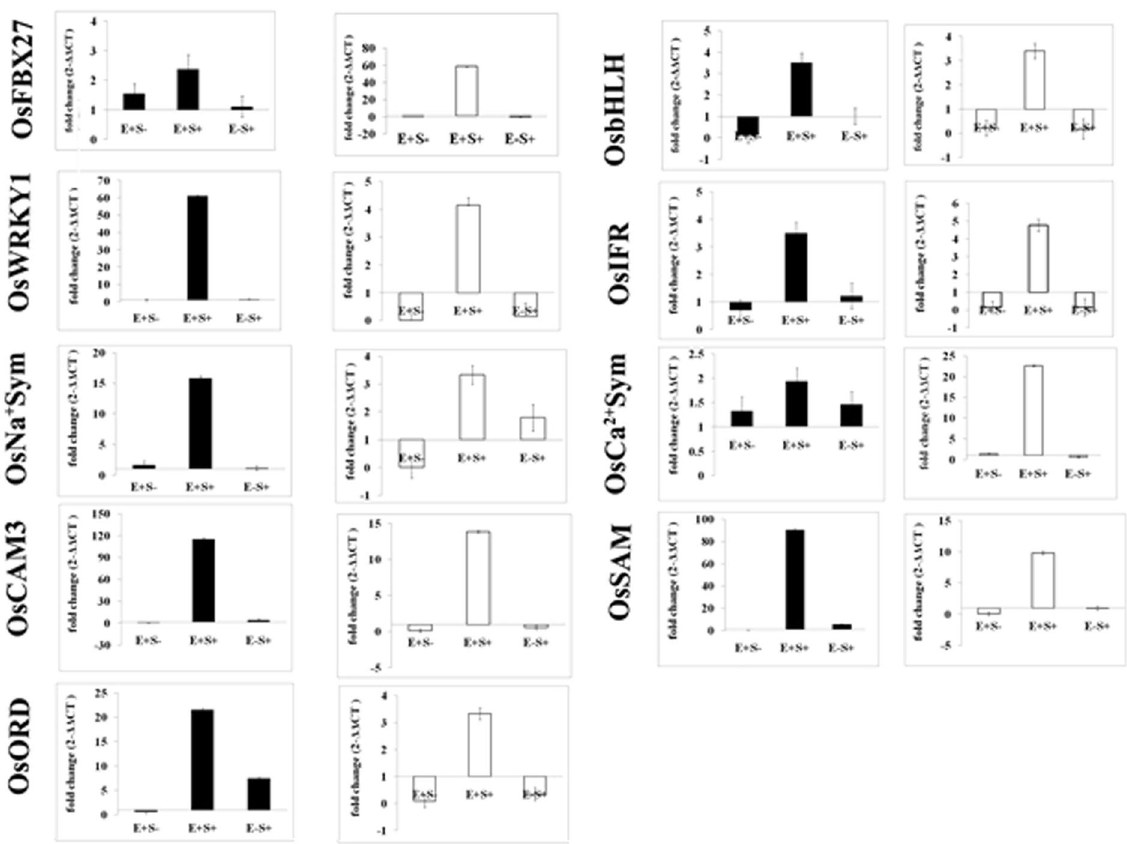
Figure 6. Validation of nine selected DGEs by qPCR. Gene expression levels at E + S − , E + S + and E − S + of shoot and root were compared to E − S − and UBQ10 (Endogenous gene) of shoot and root respectively. Black bars represent shoot and white bars represent root. Errors bars indicate mean ± standard error obtained from biological replicates.